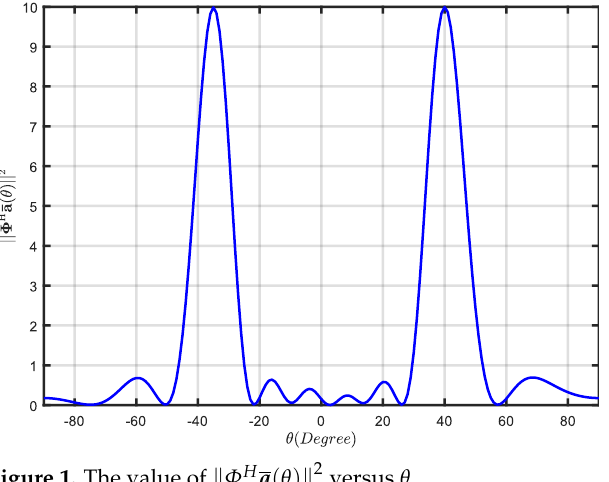
Figure 1. The value of ‖𝜱 𝐻 𝒂̅(𝜃)‖ 2 versus 𝜃 .